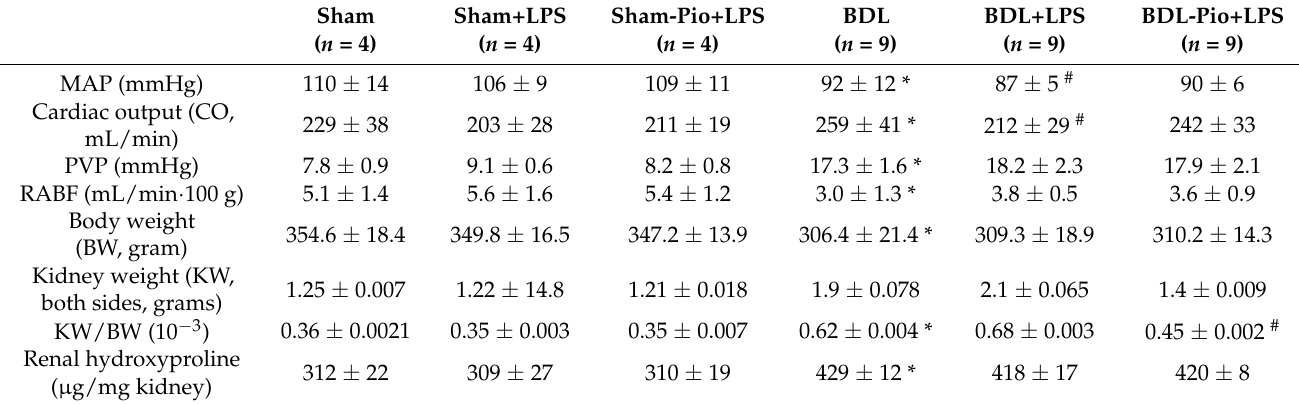
Table 2. Hemodynamic parameters of cirrhotic rats receiving chronic pioglitazone treatments after acute LPS infusion.